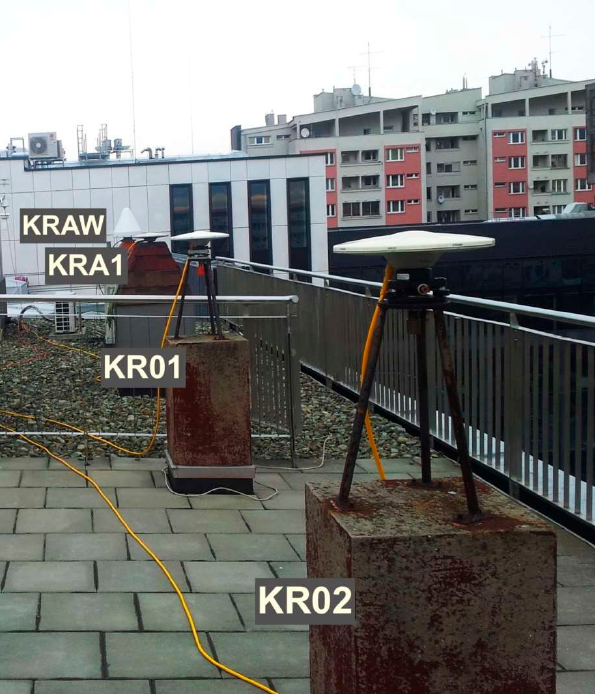
Figure 5. Location of the KRAW and KRA1 permanent stations on the roof of the AGH-UST buildings with the temporary KR01 and KR02 stations.